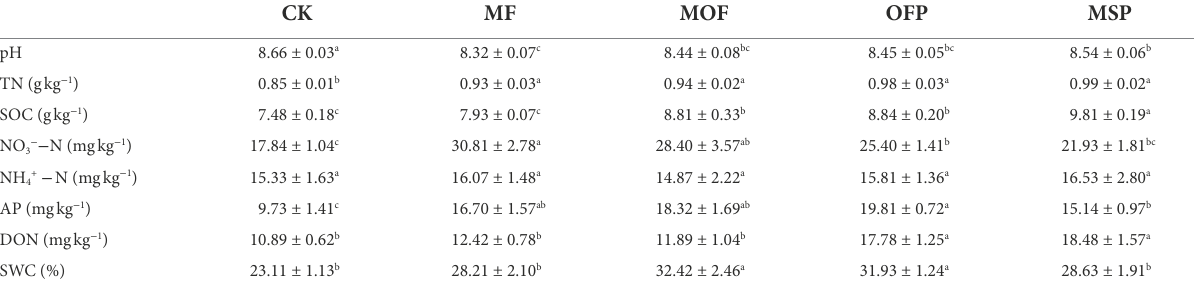
TABLE 1 Soil physicochemical characteristics under different fertilization treatments.